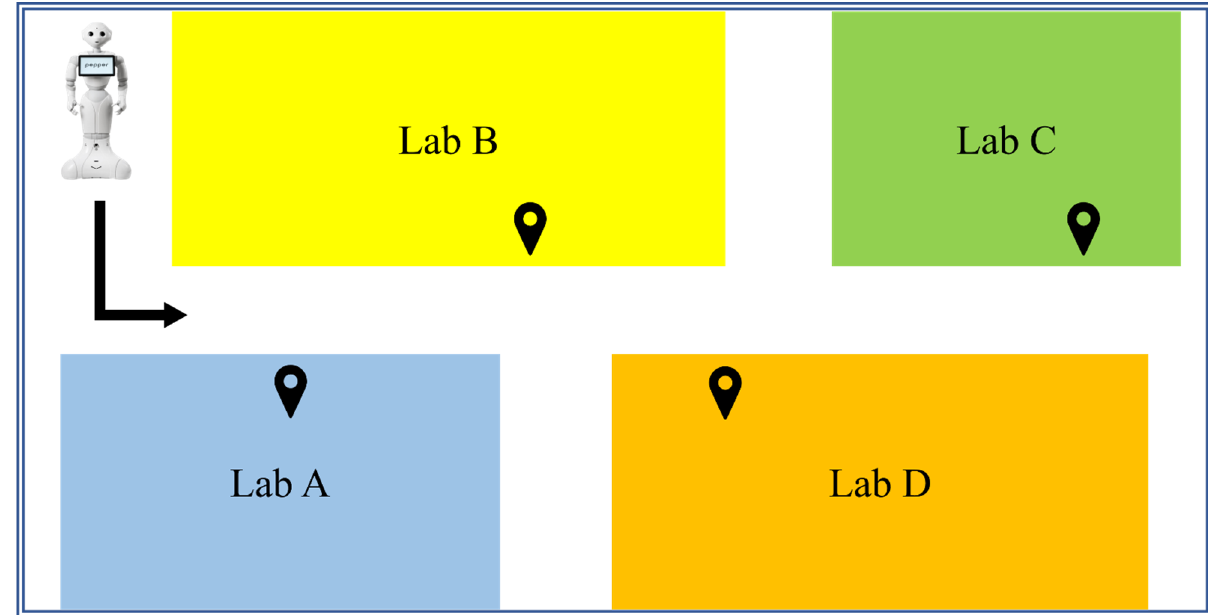
Figure 8. Schematic diagram of field test site. Table 4. Parameters for each point.